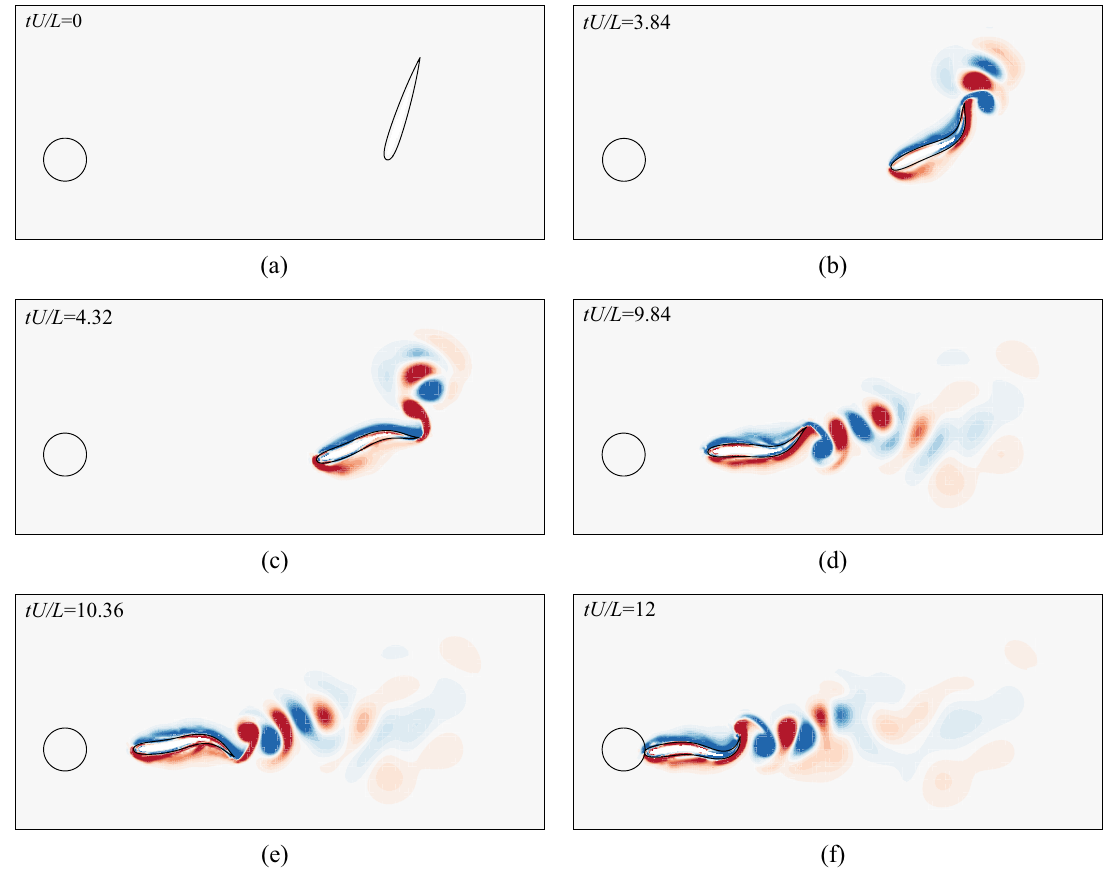
Figure 10. Vorticity contours behind the fish during point-to-point swimming at six typical instants: ( a ) 0 , ( b ) tU / L 3.84 , ( c ) tU / L 4.32 , ( d ) tU / L 9.84 , ( e ) tU / L 10.36 , and ( f ) tU / L 12 . The range tU / L = = = = = = 4 to 4. Note that the flow inside the body-occupied region is introduced by of the vorticity contours is from − the IB–LBM which however does not affect the solution in the physical region. Flow visualization is achieved by using Tecplot 360 EX 2015 R2 (https ://www.tecpl ot.com).